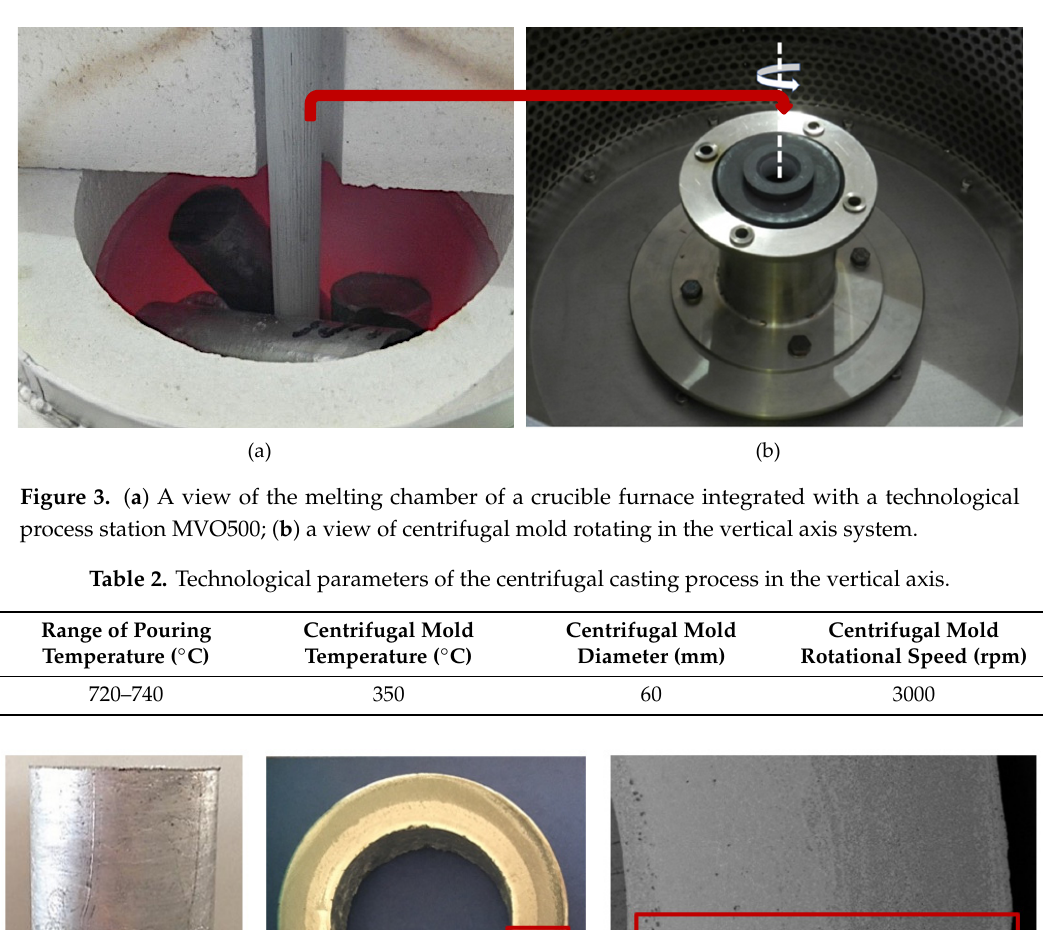
Figure 3. ( a ) A view of the melting chamber of a crucible furnace integrated with a technological process station MVO500; ( b ) a view of centrifugal mold rotating in the vertical axis system.